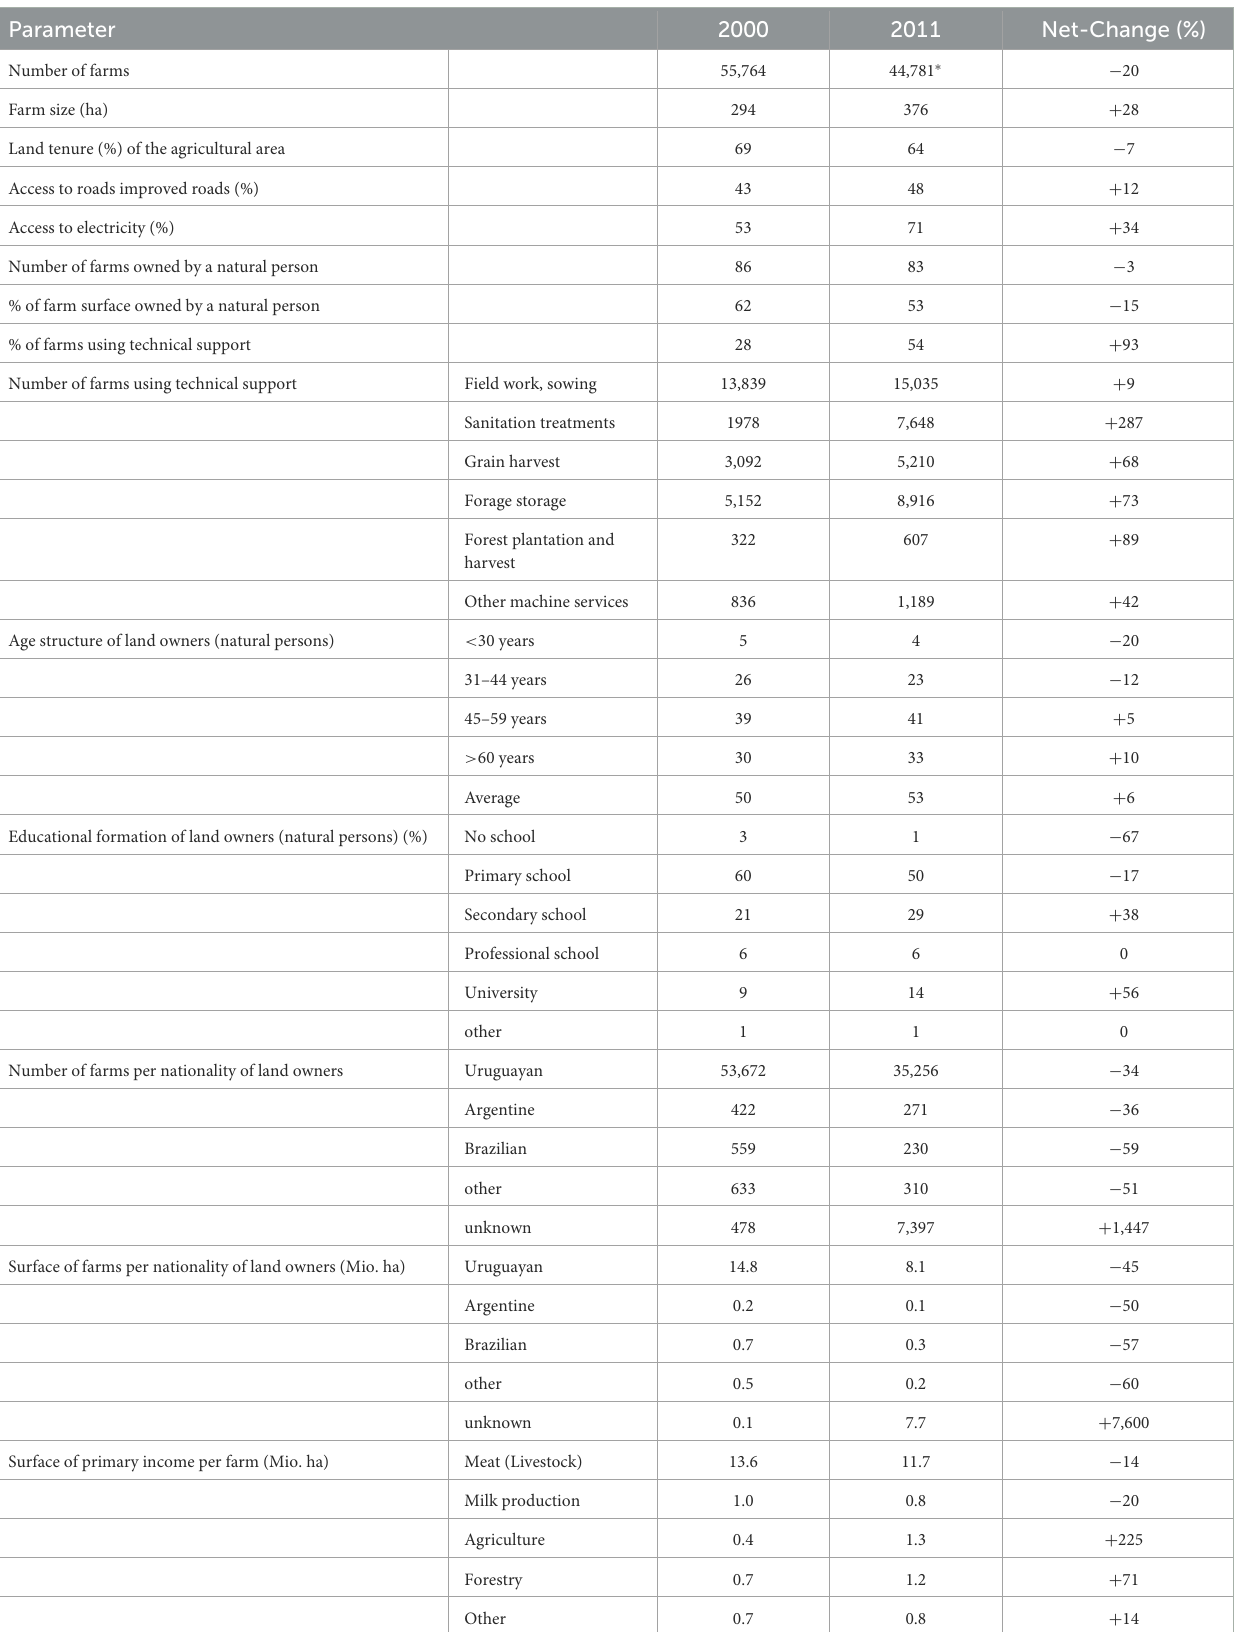
TABLE 2 Socio-economic parameters of land-use change in rural Uruguay following the General Census of Agriculture and Livestock for the years 2000 and 2011 (MGAP, 2013). Parameter 2000 2011 Net-Change (%) Number of